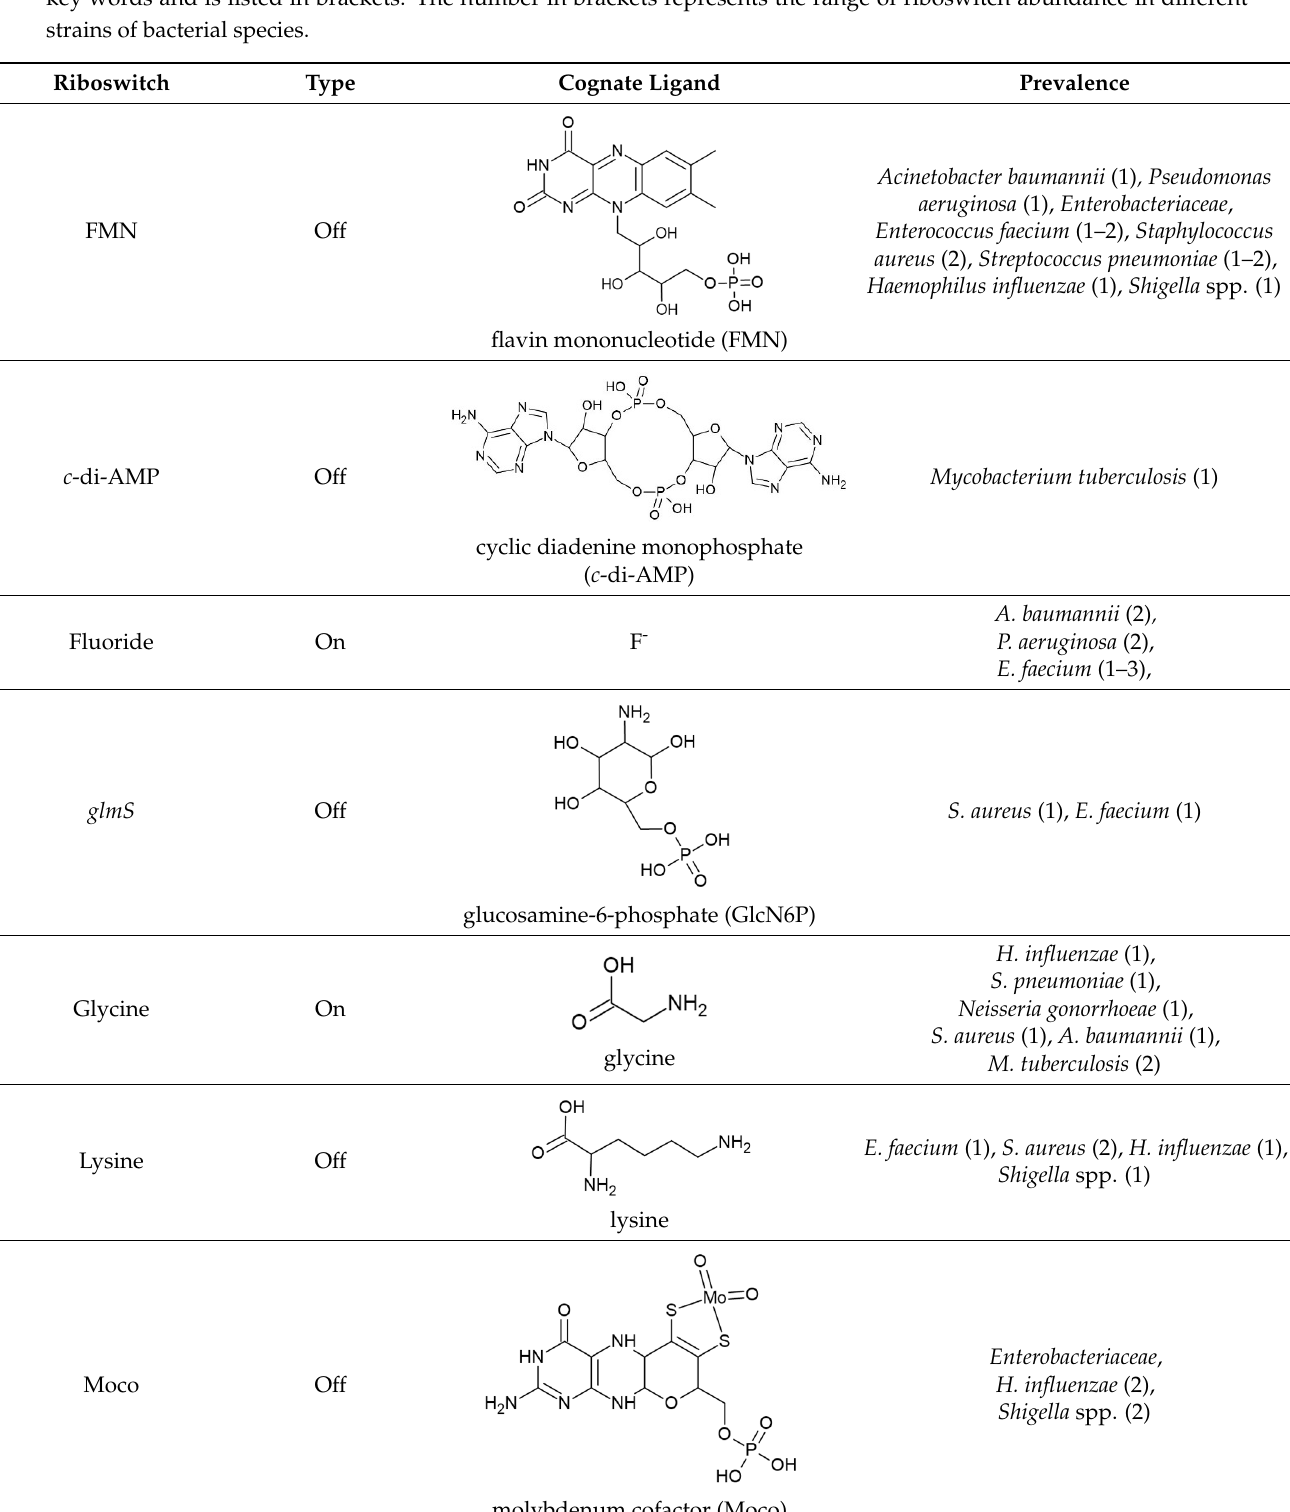
3 of 24 aptamer domain (Table 1). Biochemically, these natural ligands span a wide spectrum of biomolecules, namely coenzymes, nucleotides and their derivatives, ions, amino acids, phosphorylated sugars and guanidine. Some riboswitches are widely present across hu- man bacterial pathogens and therefore, are suitable targets for broad-spectrum antibiotics,